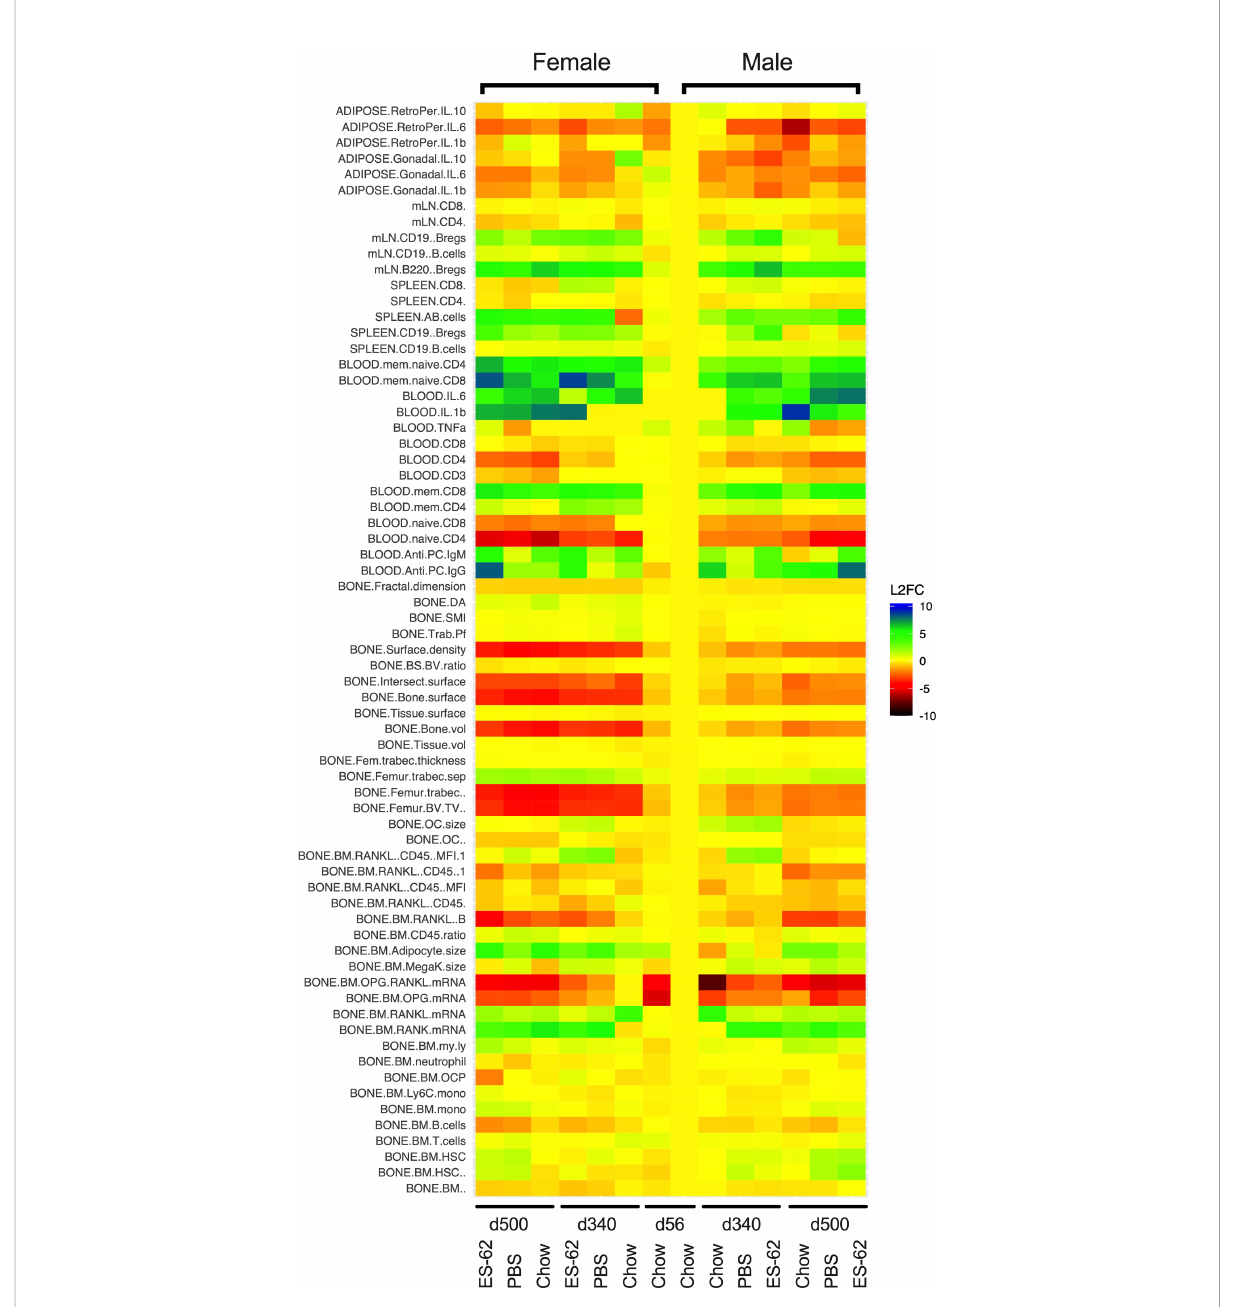
FIGURE 1 Heatmap analysis of the effects of HCD-feeding and exposure to ES-62 on parameters associated with the osteoimmunology axis. Characterisation of the indicated features of bone structure, bone marrow cellularity, differentiation and myeloid/adipocyte skewing and consequent systemic and peripheral in fl ammatory responses was carried out on tissues derived from individual young (d56) and ageing (d340 and d500) male and female mice fed normal Chow or a HCD (from d70) diet, the HCD groups being administered (s/c) PBS or ES-62 (1 µg) weekly from d63. The mean responses of the groups were determined and normalised to those of the male d56 group and the data presented in heatmap form in terms of the log2 fold response for each